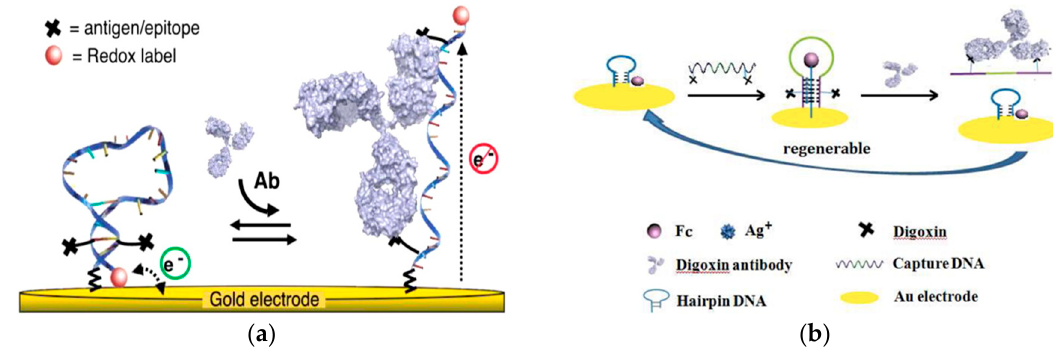
Figure 1. ( a ) Illustration of the electrochemical “switch” composed of single-strand DNA with linked antigens and methylene blue redox label. Introduction of the target antibody opens the loop and moves the redox label away from the electrode. (Adapted with permission from Ref. [28]. Copyright © 2012 American Chemical Society). ( b ) Schematic of the “triplex-stem” DNA molecular switch on gold electrode. Addition of capture DNA (middle) shows a ferrocene molecule moving away from the electrode, and digoxin antibody introduced to the system binds with digoxin on the ends of the capture DNA and causes it to be released, converting the triplex system to hairpin DNA with ferrocene close to the electrode surface. (Adapted from Ref. [29]. Copyright © 2014 Elsevier B.V.)